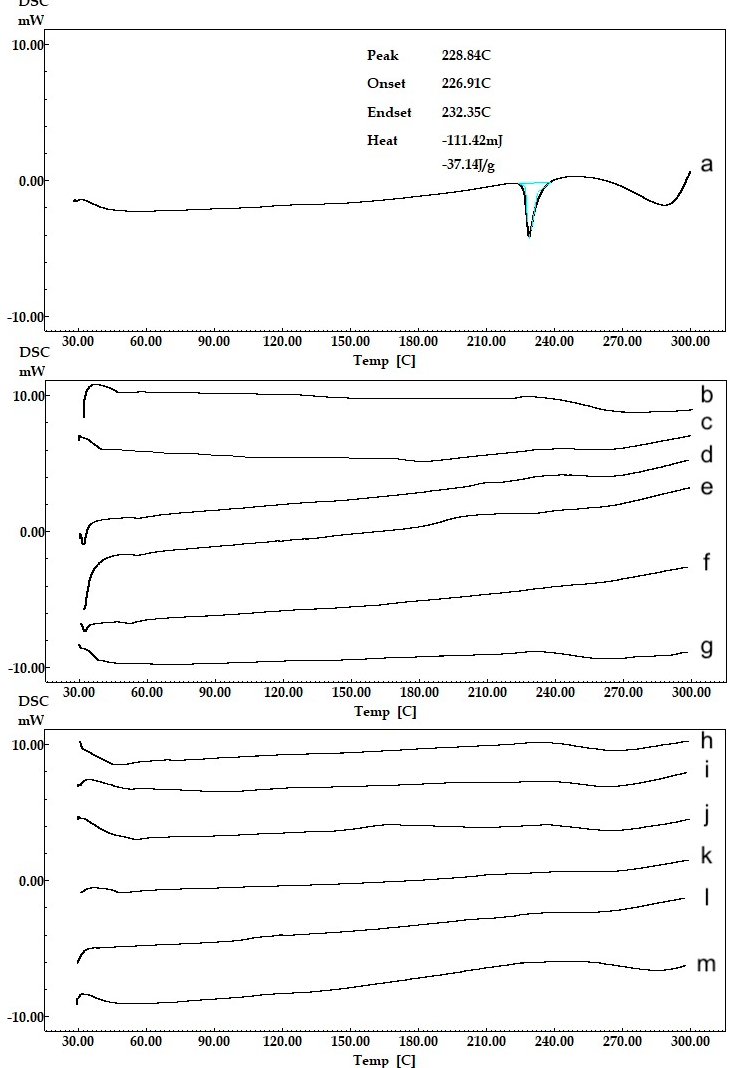
Figure 5. Thermal (DSC) analysis curves of CLR and NPs, ( a ) CLR, ( b ) 502H-Blank, ( c ) 503H-Blank, ( d ) 504H-Blank, ( e ) CS-502H-Blank, ( f ) CS-503H-Blank, ( g ) CS-504H-Blank, ( h ) 502H, ( i ) 503H, ( j ) 504H, ( k ) CS-502H, ( l ) CS-503H, ( m ) CS-504H.